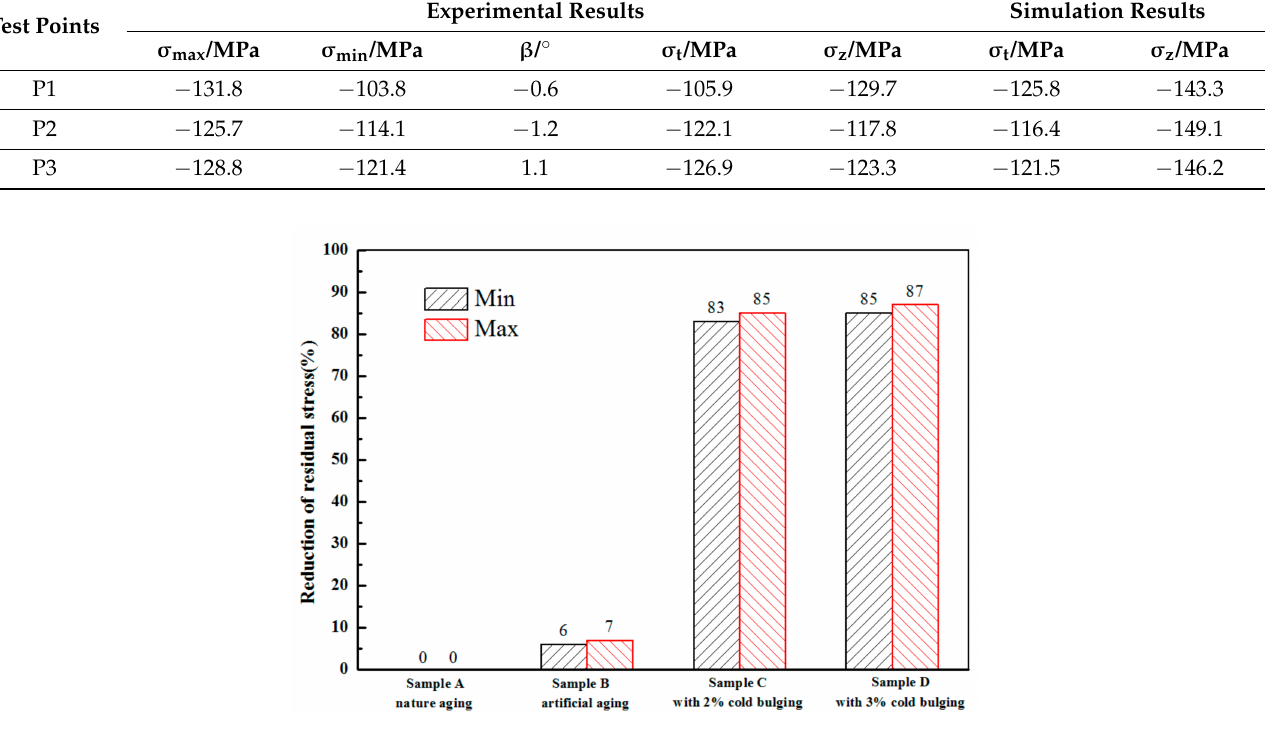
Figure 13. Comparison of residual stress reduction percentage between artificially and naturally aged